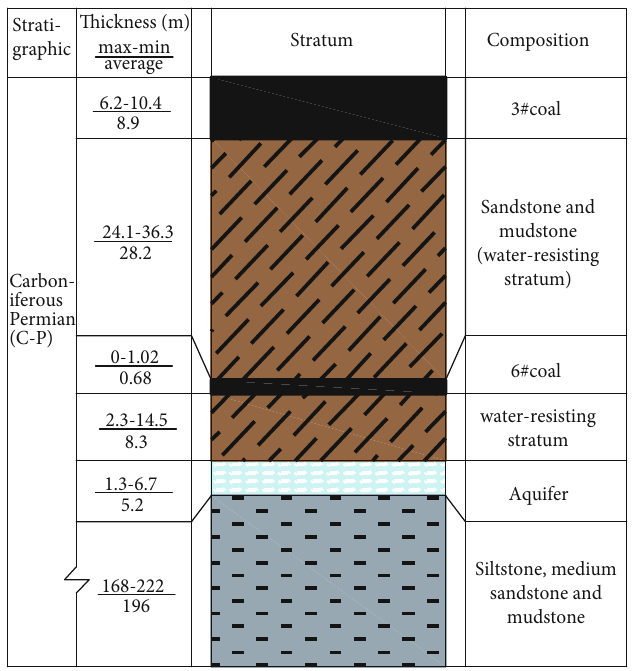
Figure 1: Comprehensive column diagram of the hydrogeology of the underlying strata.